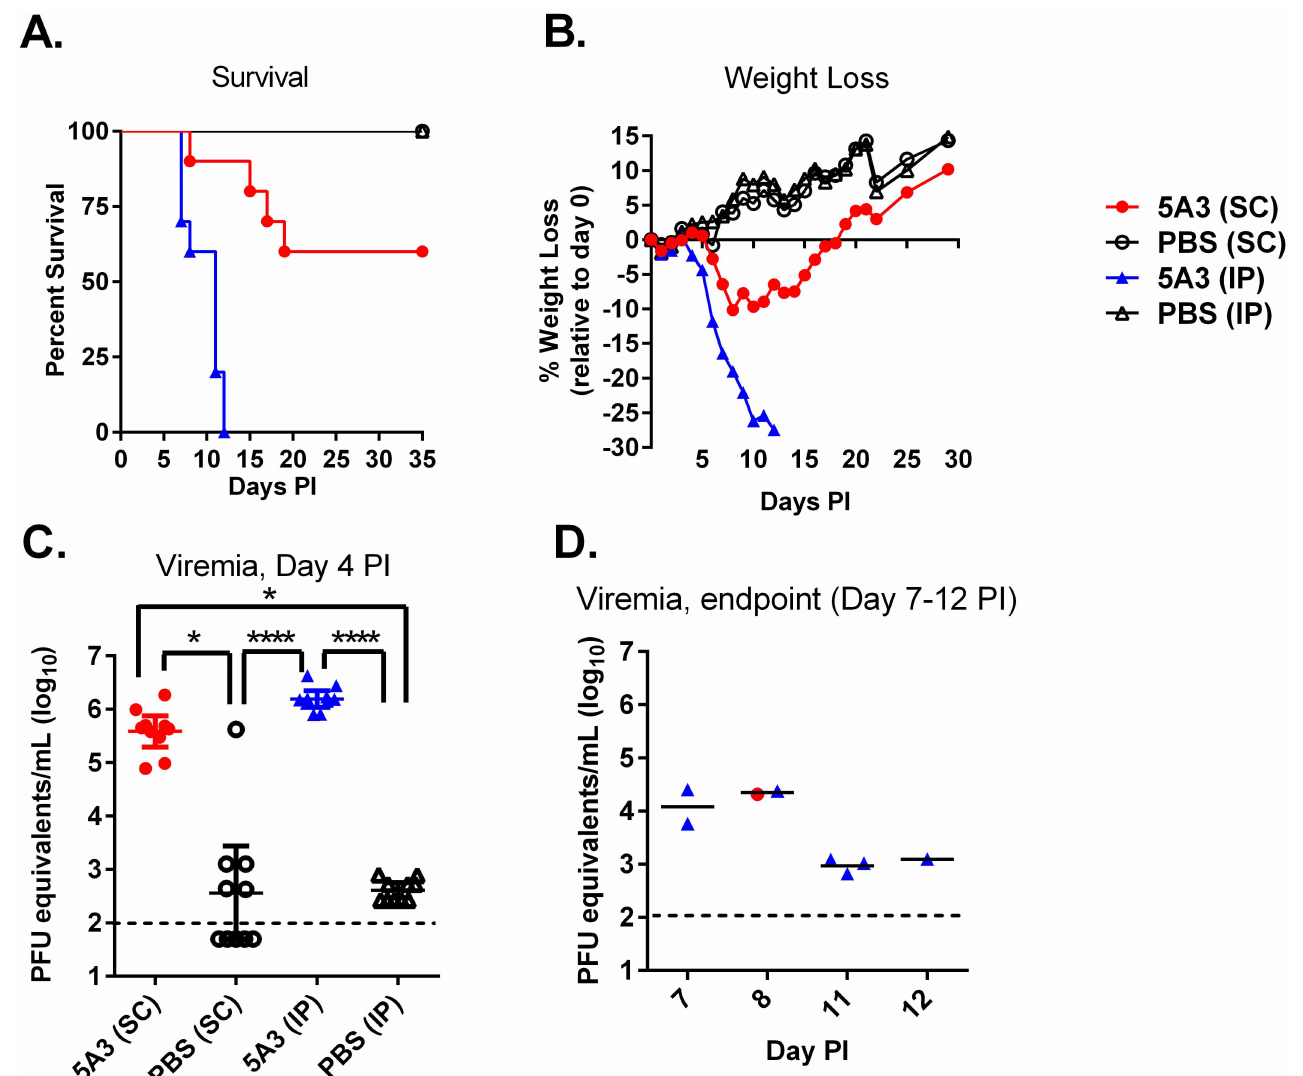
Fig 1. Wild-type Mice Treated with an IFNAR1-Blocking MAb are Susceptible to ZIKV. Five week old wild-typemice were treated with an IFNAR1-blocking MAb or PBS by intraperitoneal (IP) injectionand then exposedto 6 log 10 of ZIKV strain DAK AR D 41525 subcutaneously (SC) or IP. Mice were monitored for survival (A) and weight loss shown as percent changein baselineprior to infection(B). ZIKV RNA in serum was determinedon day 4 post-infection (PI) (C) and when the mice were euthanized (D) by qRT-PCR. Data are shown as PFU equivalents (PFUe) per milliliterafter normalization to a standard curve. Symbols represent the individualmice, the line represents the geometric mean, and the error bars represent the 95% confidenceinterval. The dotted line represents the assay limit of detection. Statistically significantdifferences are denotedby an asterisk ( * p < 0.05; * p <